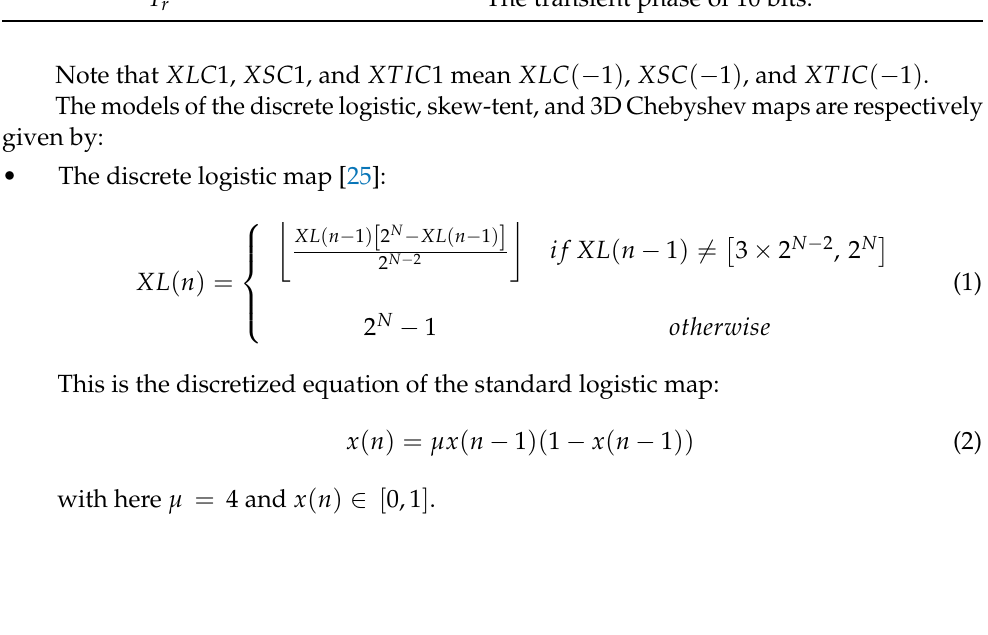
The coefficients of the recursive cells: logistic, skew-tent, KL, KS, and KT and 3D Chebyshev respectively, ranging from 1 to 2 N − 1. The control parameter of the skew-tent map, in the range P s [ 1, 2 N − 1 ] . The parameters of the coupling matrix M, in the interval (cid:101) ij [ 1, 2 k ] with k ≤ 5. T r The transient phase of 10